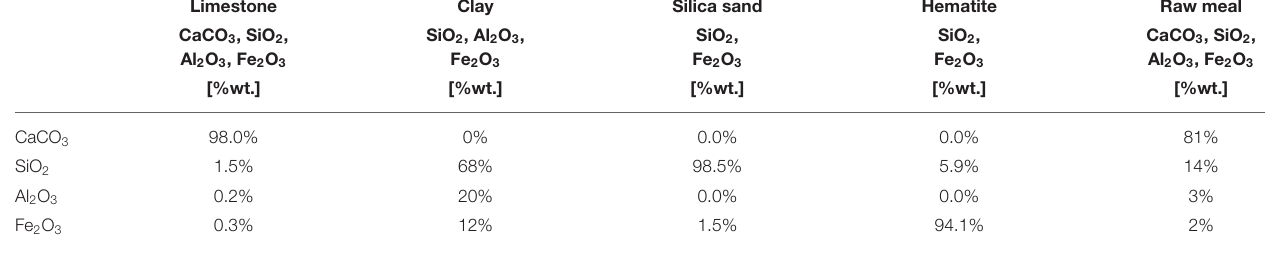
TABLE 1 | Raw meal composition considered as input to the clinker production process. Limestone Clay